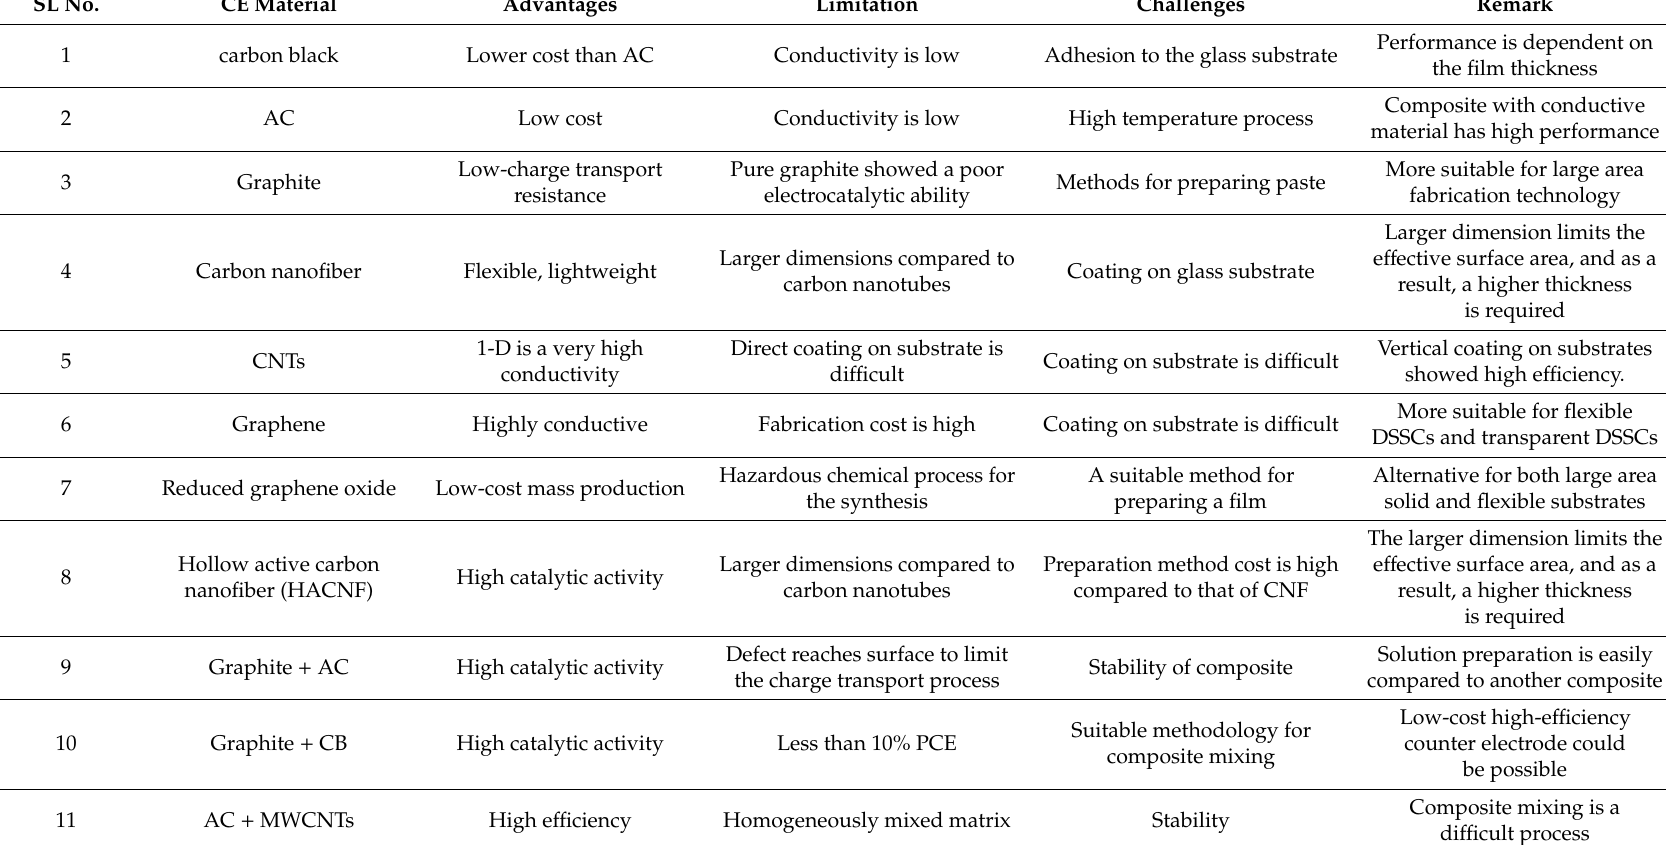
Table 4. Advantages and disadvantages of di ff erent carbon counter